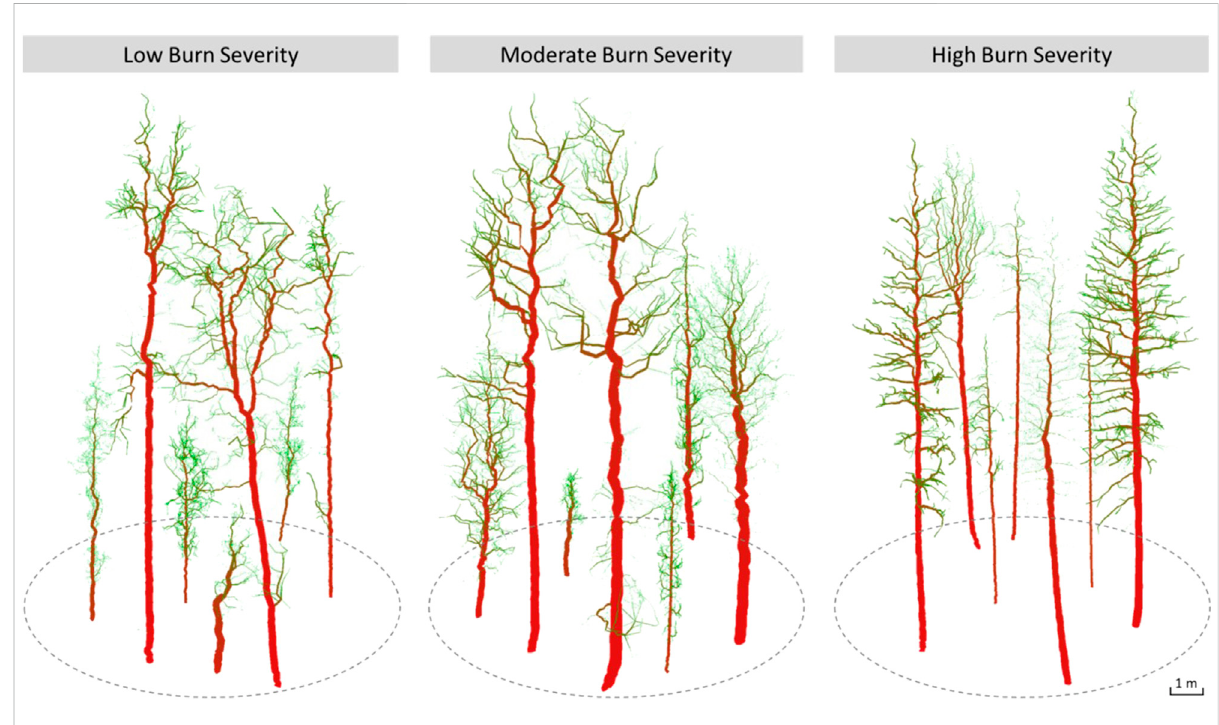
FIGURE 6 Examples of individual tree QSMs from low-, moderate-, and high-severity study